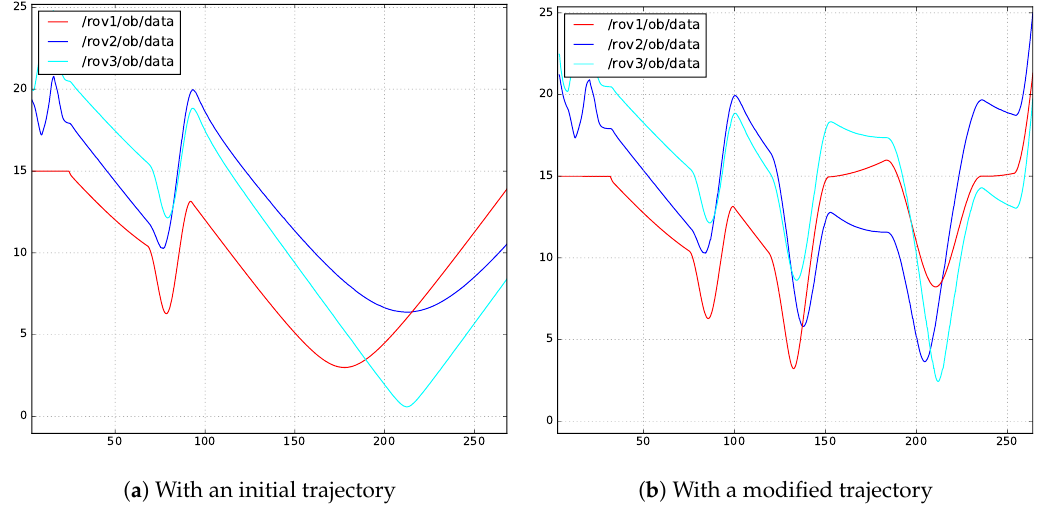
Figure A3. The distances from the UUV i to the